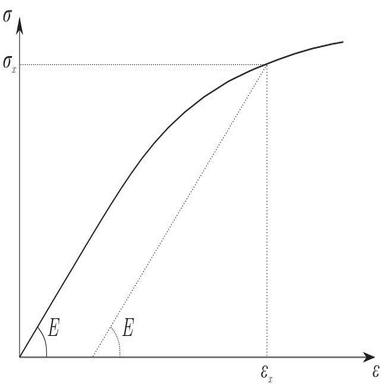
Generalised form of single stage Ramberg–Osgood model.